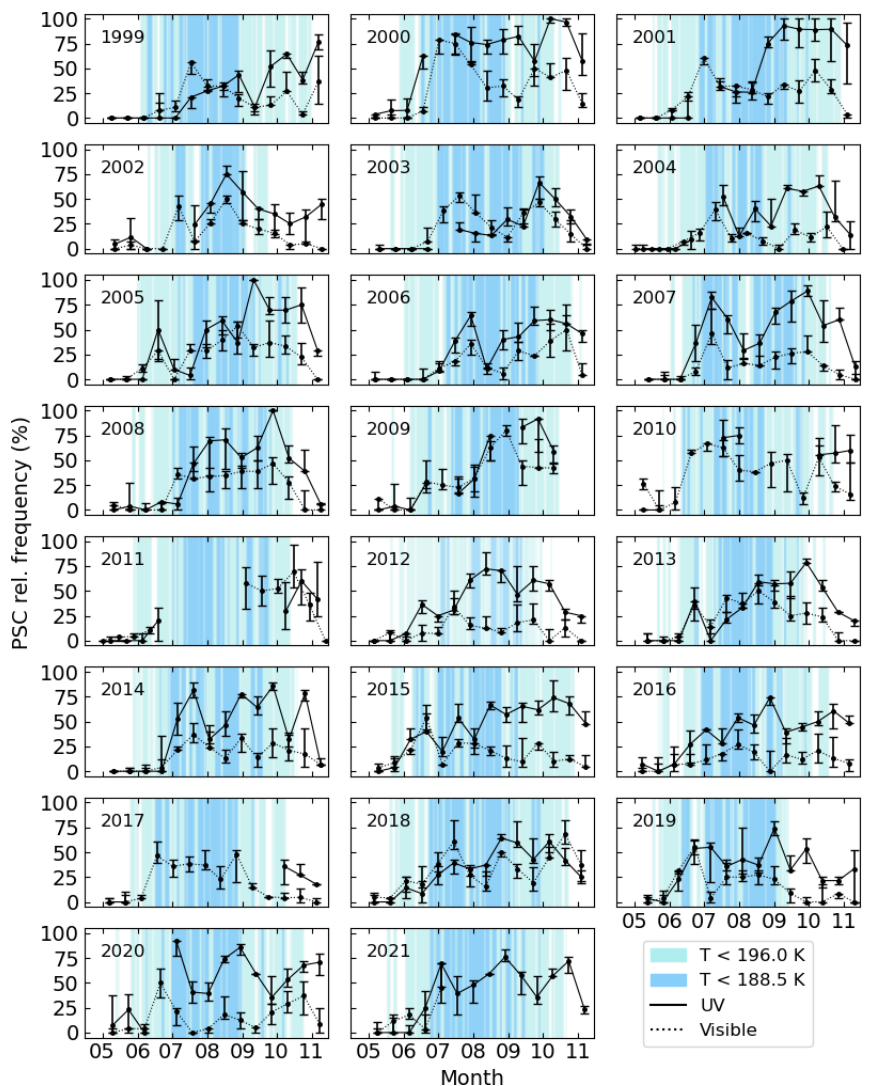
Figure 11. Biweekly relative frequency of PSCs in the UV (solid) and visible (dotted) spectral range for each year from May to November above the Neumayer station. In the background, the temperature ranges important for PSC formation are indicated by the blue shading. Data are plotted from the ECMWF subset (at 50hPa) sampled in the vicinity of the measurement